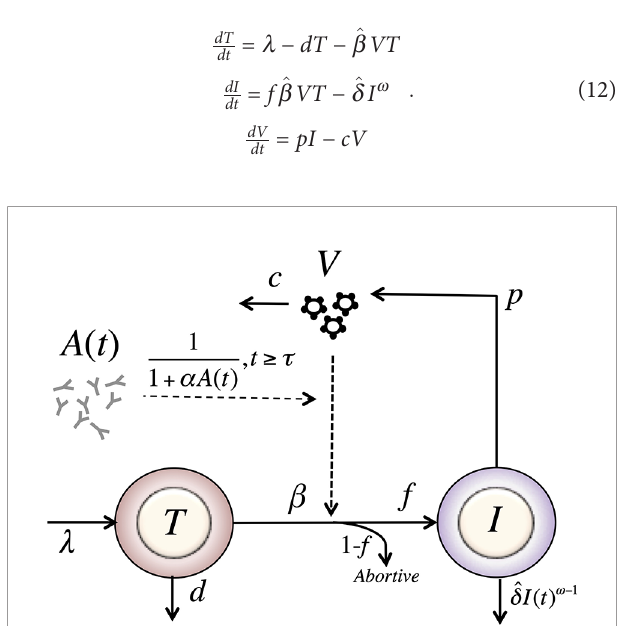
FIGURE 3 | Schematic of the delayed-neutralization model. The model includes three variables: target cells ( T ), productively infected cells ( I ), and free virus ( V ), Parameters l , d and b are the production, death and infection rates of target cells; d is the death rate of infected cells; p and c are the production and clearance rates of free virus. Antibodies decrease the infectivity after a delay t , with sensitivity a . The antibody concentration, A ( t ), is determined from the best fi ts of the two-compartmental model to VRC01 concnetration measurements for each individual (see